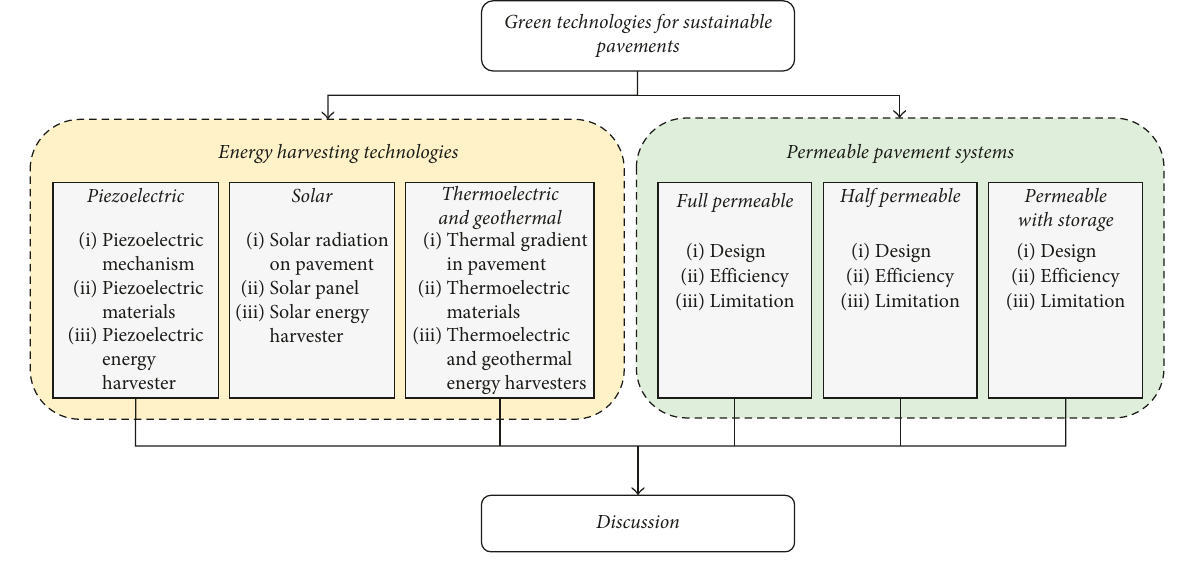
Figure 2: Outline of this